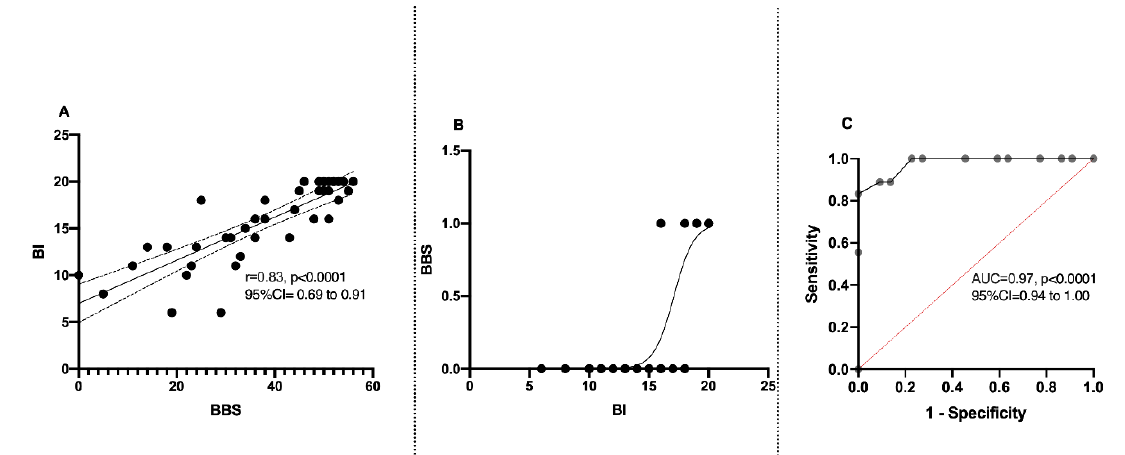
Figure 2. Relation between balance (BBS) and Barthel index (BI): ( A ) correlation between BBS and BI; ( B ) regression curve on BBS and BI; ( C ) ROC curve between BBS and BI.